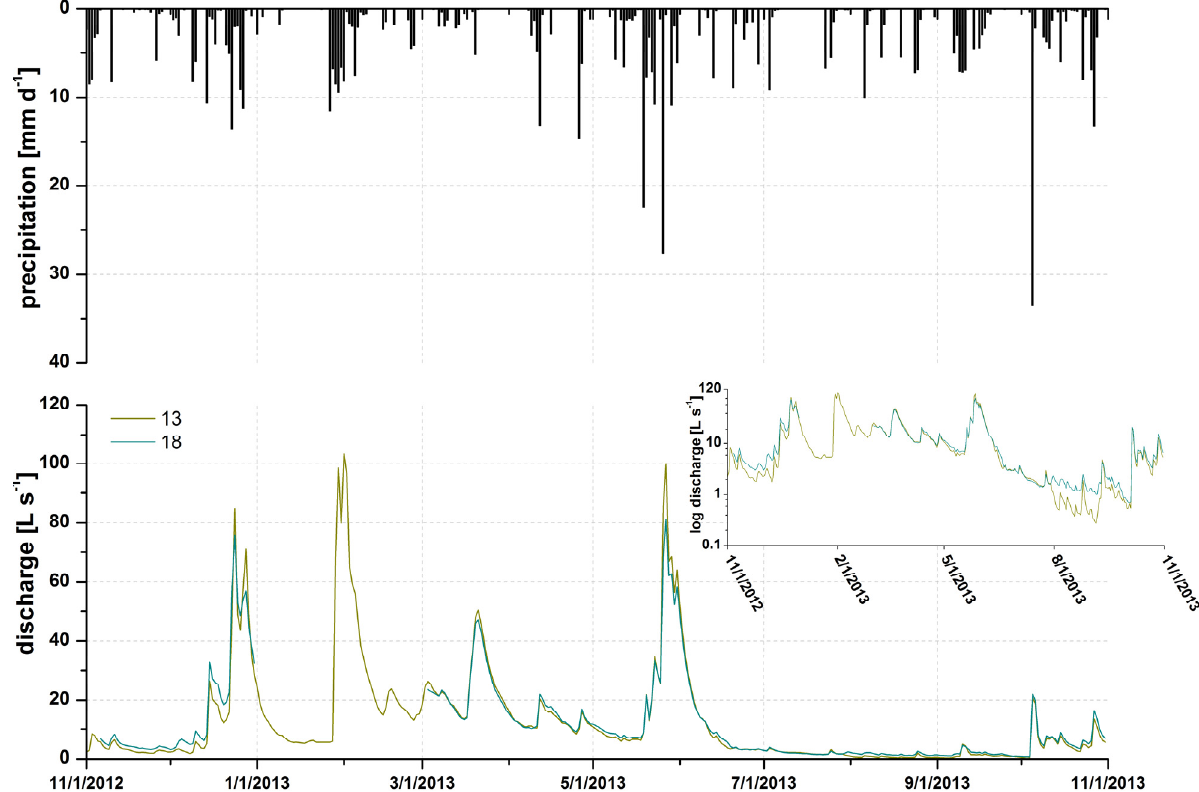
Figure 3. Time series of daily precipitation (mm·d − 1 ) and discharge (L·s − 1 ) at the lower and upper RBC-flume (13, 18) for the water year 2012–2013. Small inset includes discharge plotted on a logarithmic